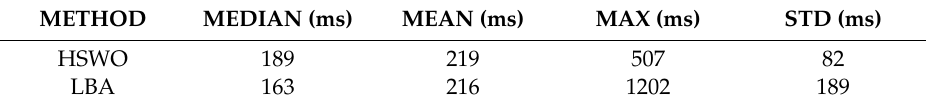
Table 3. Time consumption of the HSWO and LBA method.